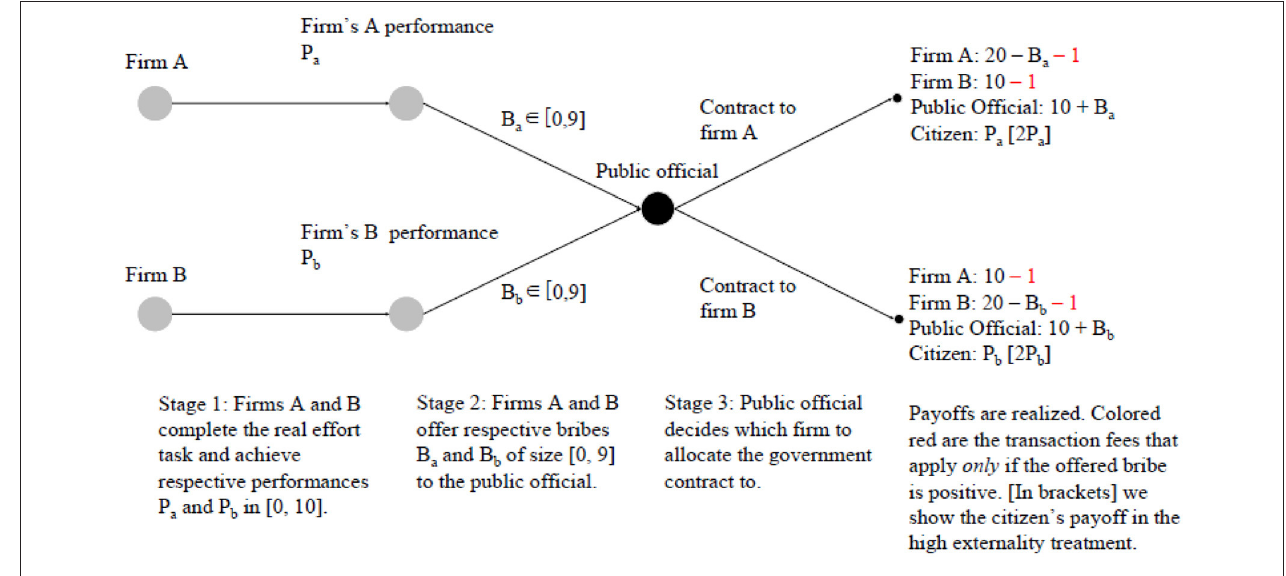
FIGURE 1 | The game tree.